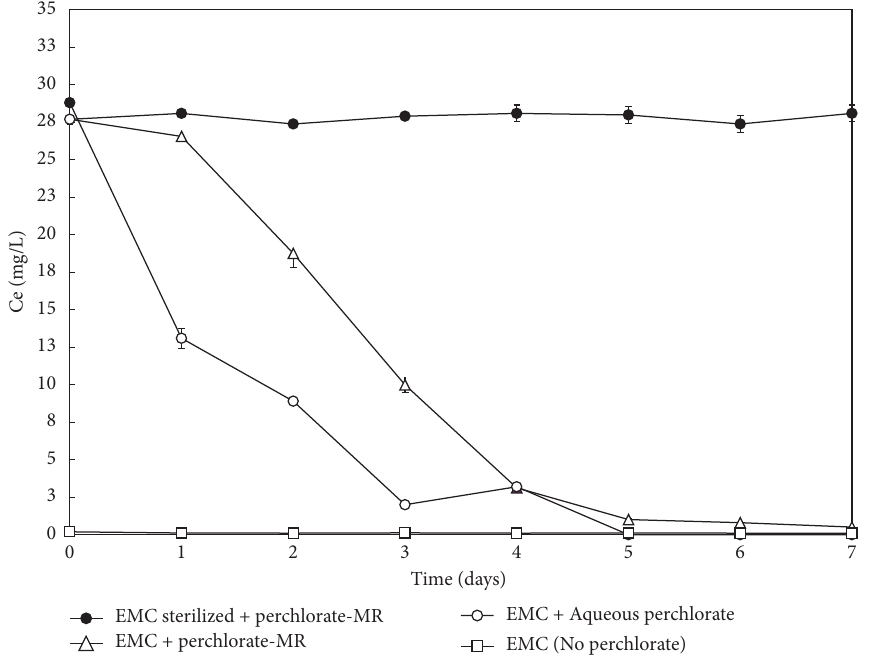
Figure 3: Biological removal of perchlorate adsorbed on quaternary-ammonium MR by EMC sustained on brewer’s yeast as an electron donor. Te initial conditions were: [ClO 4 − ] added to MR � 30mg/L; MR � 2.0g/L; yeast � 0.1 g; pH � 7.0 ± 0.5; T � 25 °